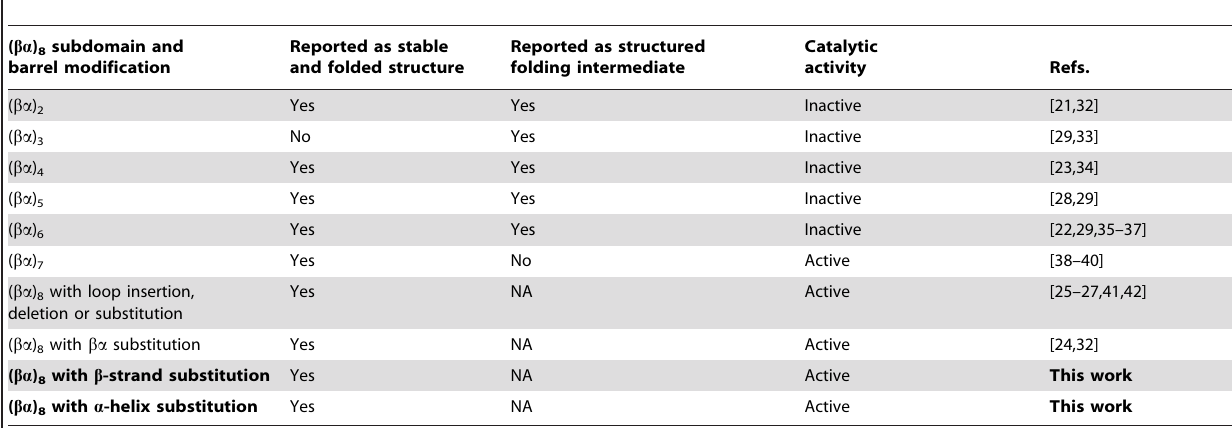
Table 1. ( ba ) 8 subdomains and barrel modifications reported by protein engineering